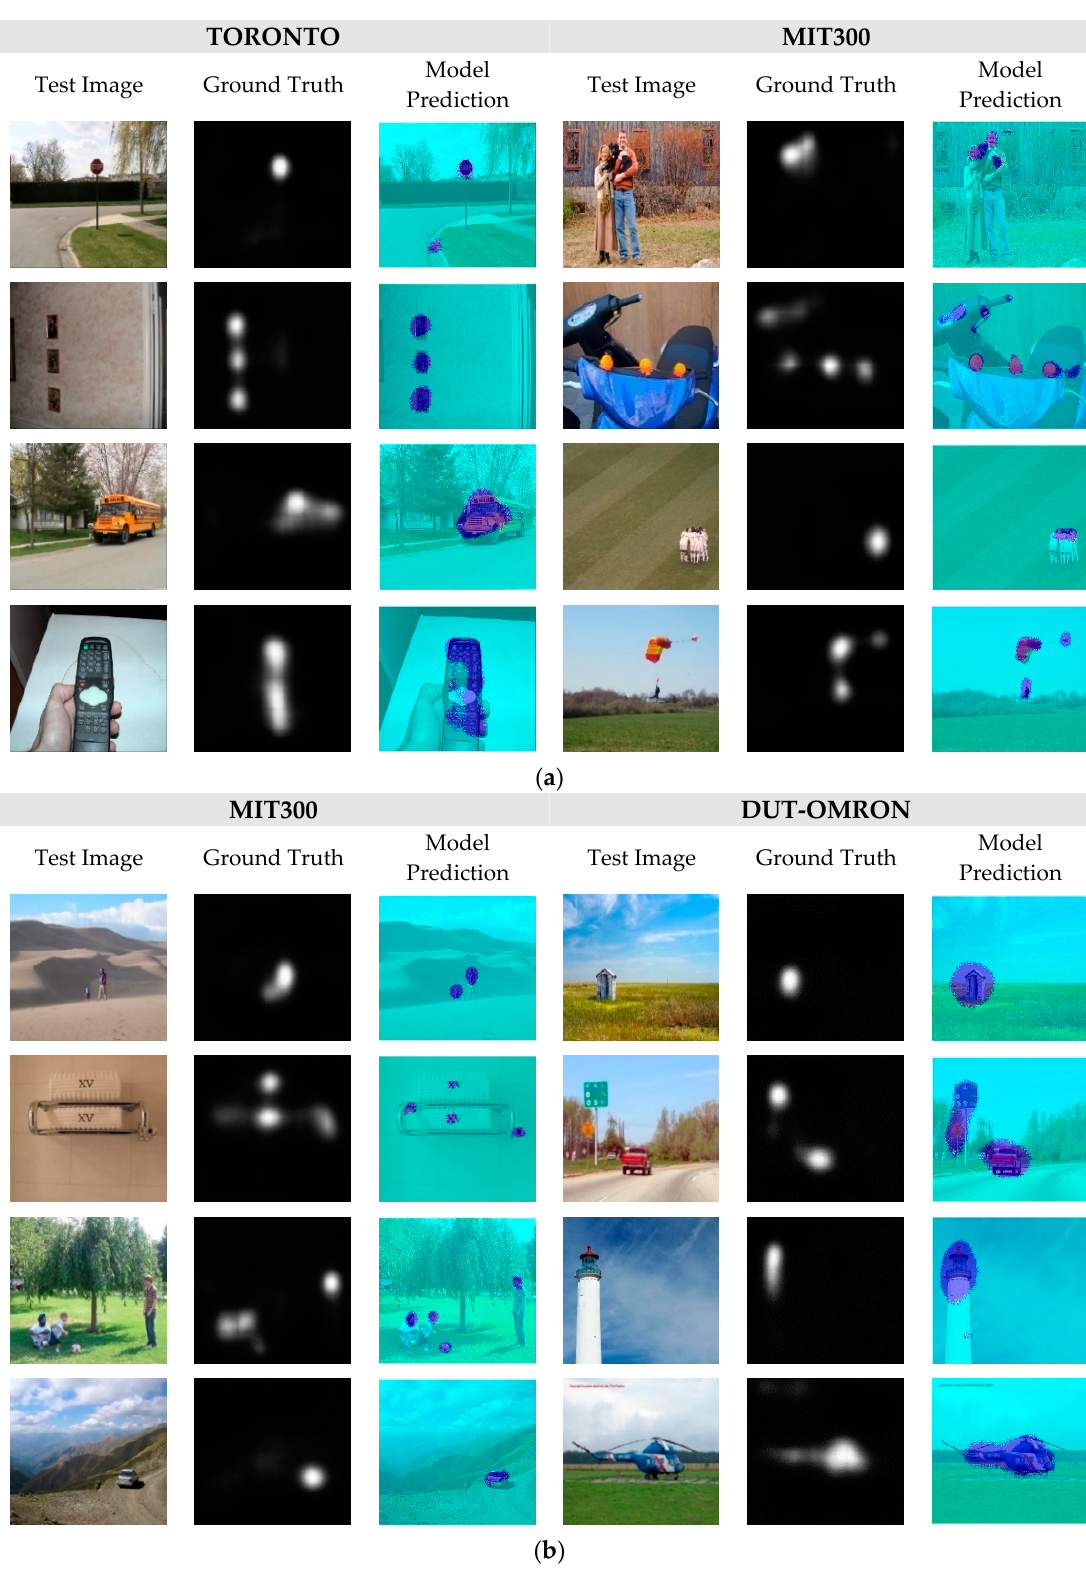
Figure 4. Model testing: ( a ) TORONTO and MIT300 datasets, and ( b ) MIT1003 and DUT-OMRON datasets.